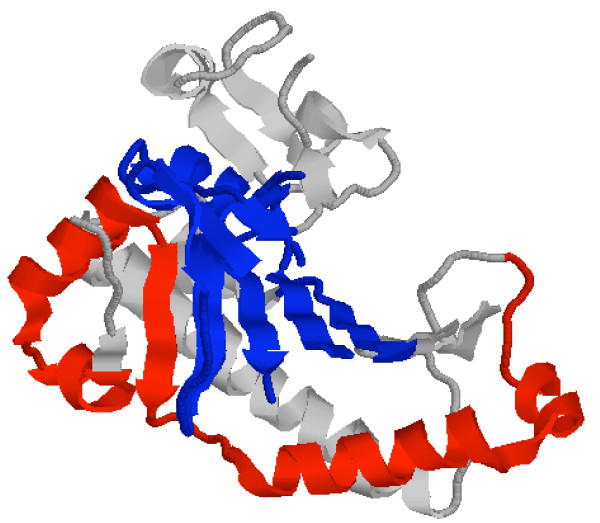
EVEREST family EV01.02755. [PDB:1UOG], a representative protein structure containing an [EVEREST:EV01.02755] domain (in red) and a [Pfam:PF03171] domain (in blue). Notice that [EVEREST:EV01.02755] defines a domain distinct from [Pfam:PF03171]. For details of this example see Putative new domain family in section Examples: Selected EVEREST Families.